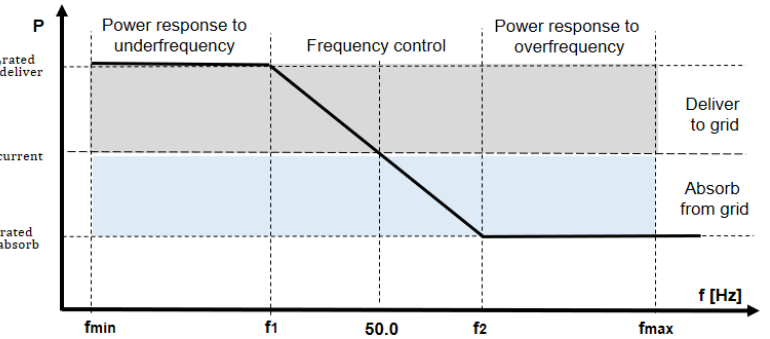
Figure 4. Frequency control for an electrical energy storage plant in Denmark. Standard frequency settings are fmin = 47.5 Hz (DK1/DK2), fmax = 51.5 Hz (DK1/DK2), f1 = 49.8 Hz (DK1)/49.5 (DK2), f2 = 50.2 Hz (DK1)/50.5 Hz (DK2), droop = 5% of Pn (DK1)/4% of Pn (DK2).